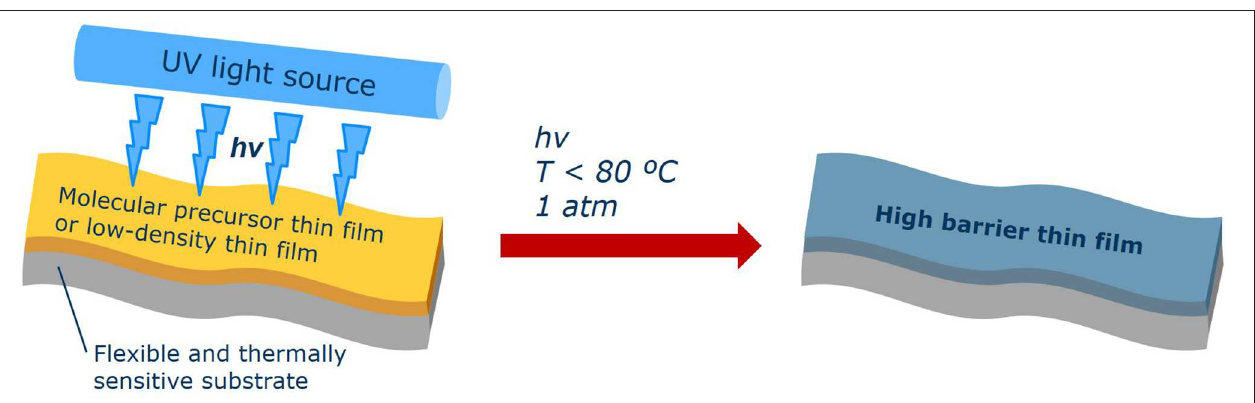
FIGURE 3 | Schematic of UV photoconversion process of precursor films onto polymer